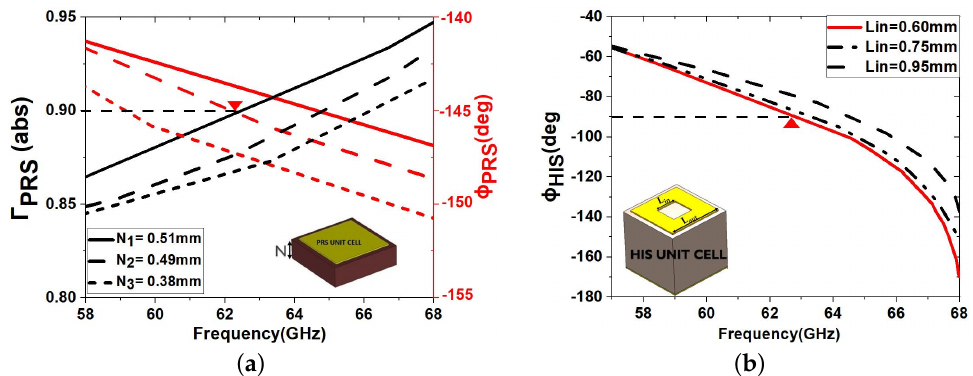
Figure 3. ( a ) Magnitude and phase reflection coefficient of the PRS unit cell. ( b ) Phase reflection coefficient of the HIS unit cell with respect to L in with L out = 1.50 mm.